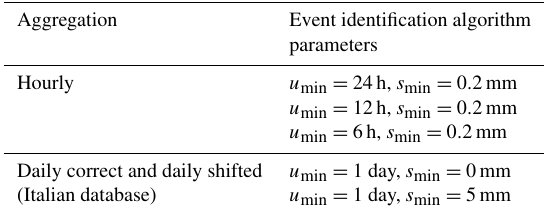
Table 4. Set-up of the numerical experiments. Each set of algorithm parameters is considered for the four hypothesized landslide report- ing